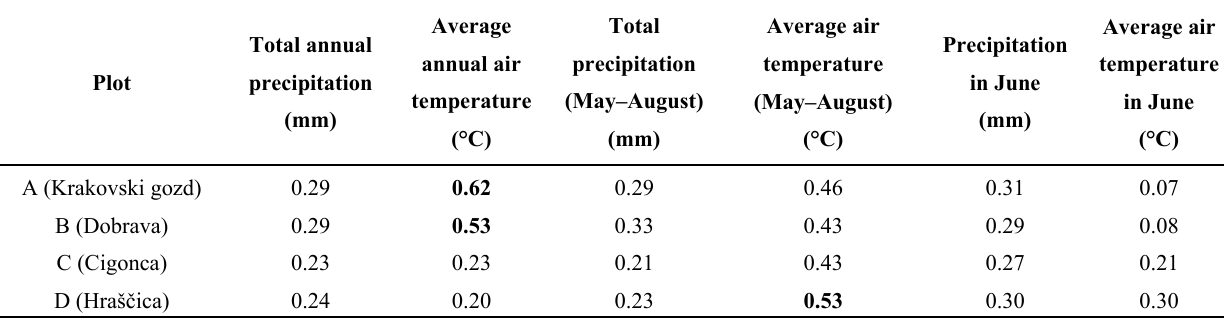
Table 3. Correlation coefficients ( r 2 ) between groundwater vs. total precipitation and average air temperatures in different periods (1995–2013). Values higher than ( r 2 = 0.50) are marked in bold.